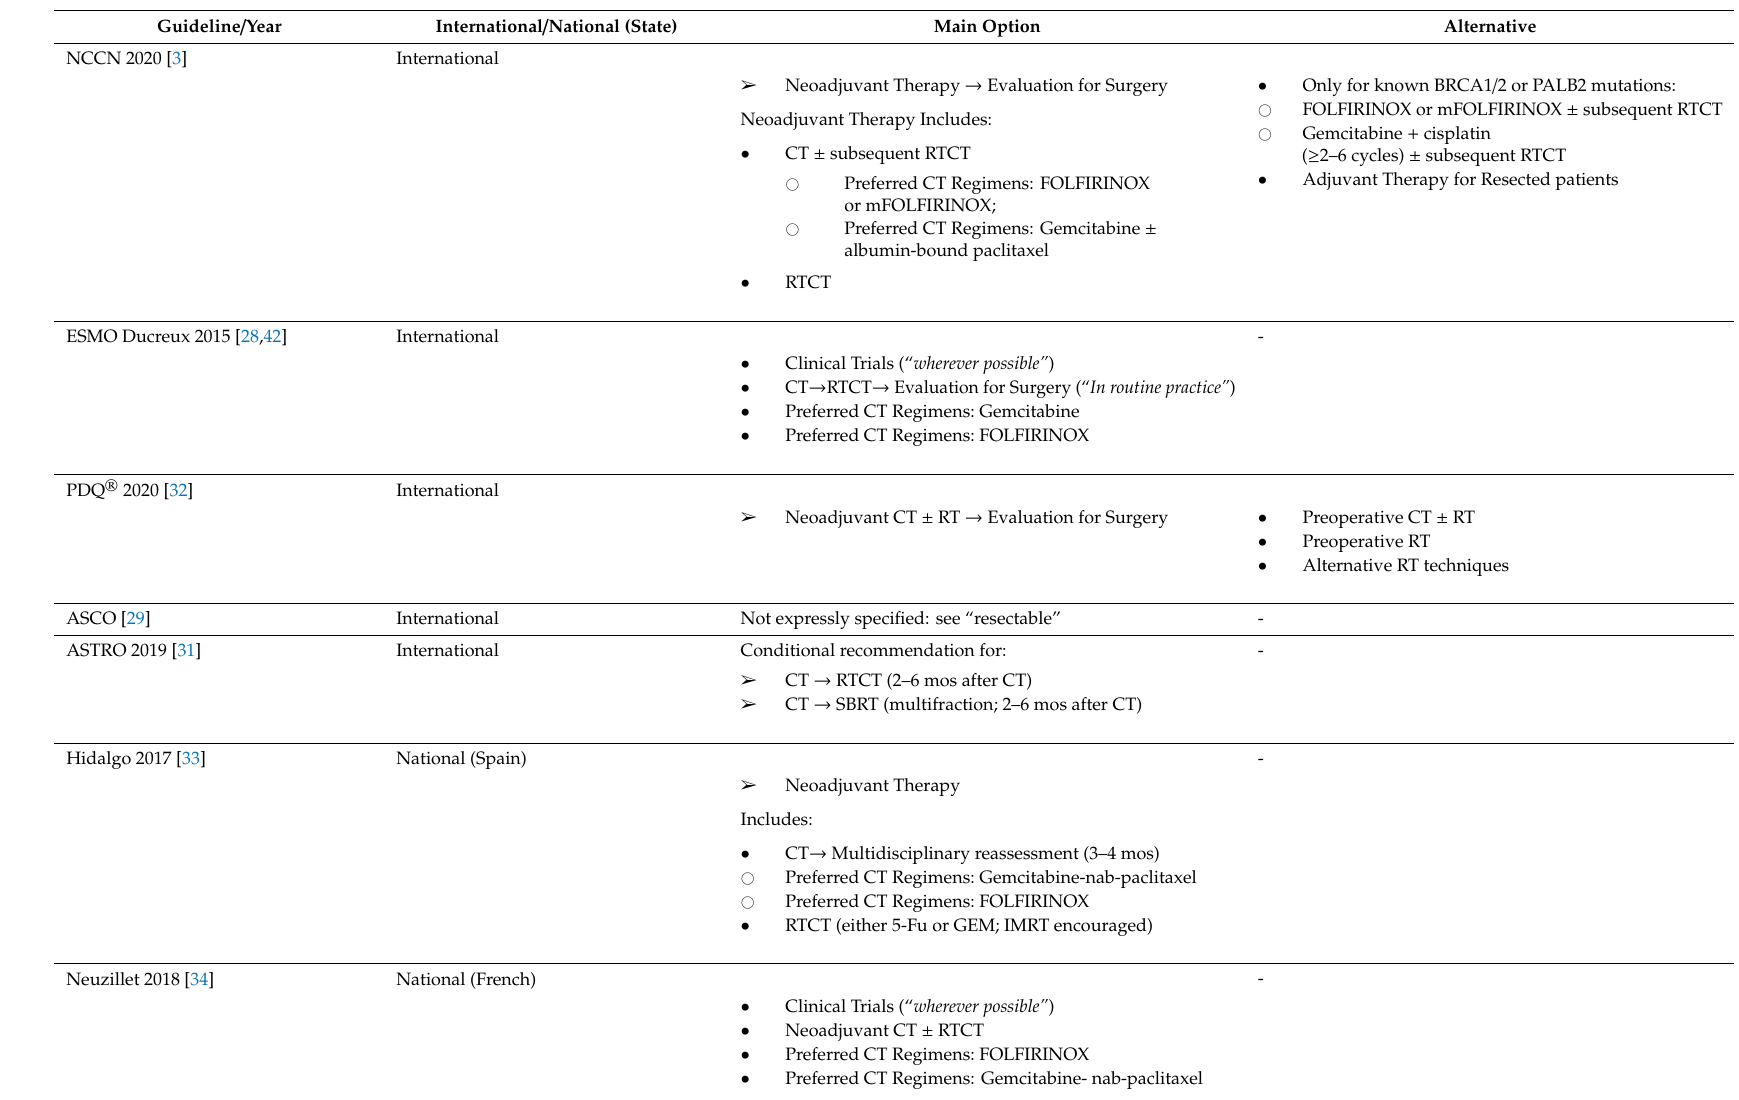
Table 3. Clinical presentation: Borderline Resectable Pancreatic Cancer